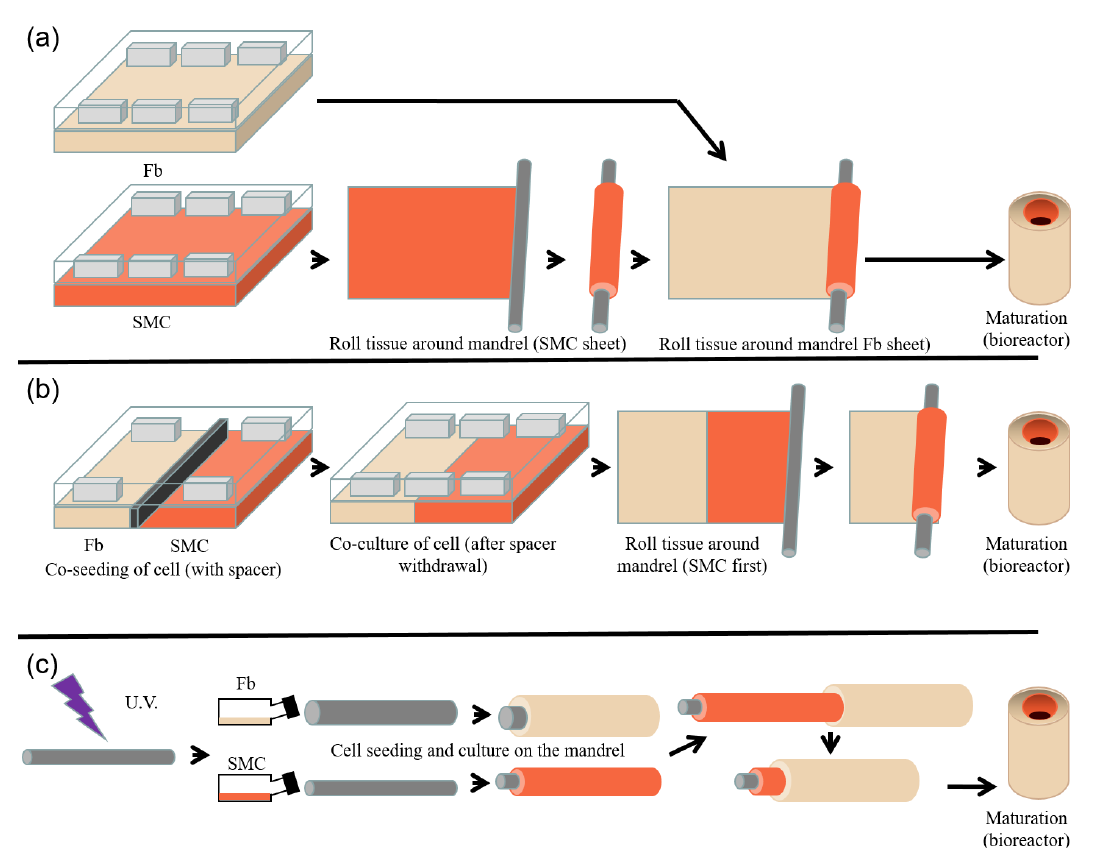
Figure Figure 3. The self-assembly method and its improvements to produce vascular grafts. ( a ): Original method (L’Heureux et al.); ( b ): One-step method (Gauvin et al.); ( c ): Alternative method (Galbraith et al.).